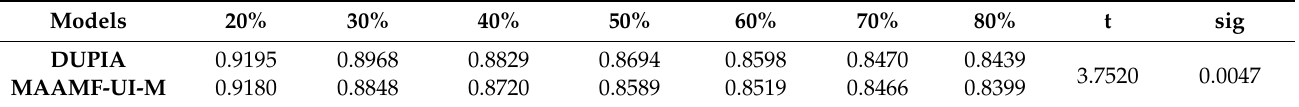
Table 6. The p-value of the one-tailed paired t-test between the DUPIA model and the MAAMF-UI-M model. Models DUPIA